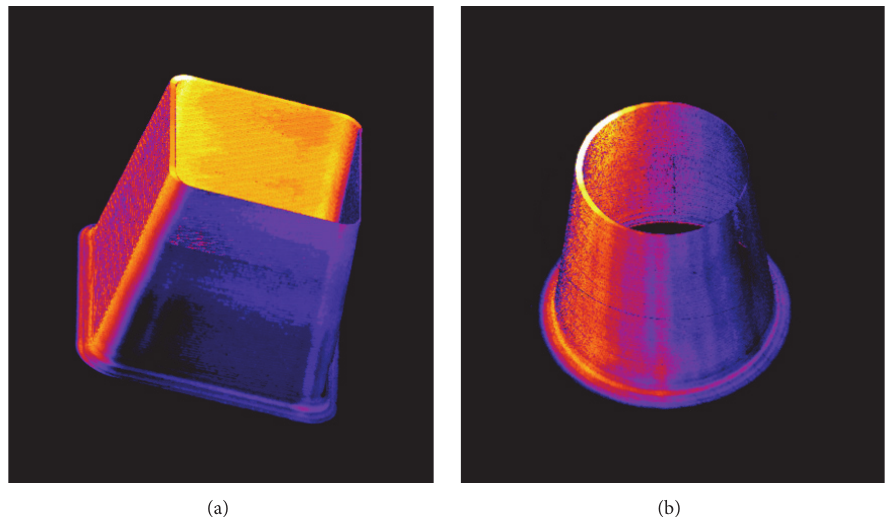
Figure 13: 3D visualization of gap dimension (obtained using the MCS algorithm). (a) Pyramidal shape. (b) Conical shape. White color corresponds to the maximal gap size of each case.